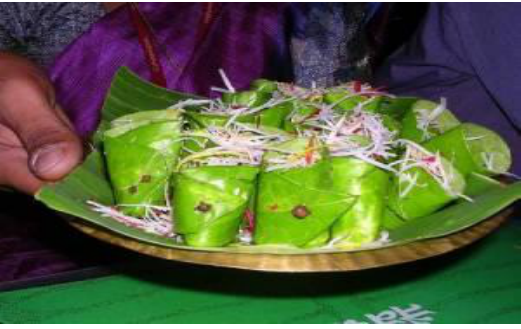
Figure 16. Sweet paan